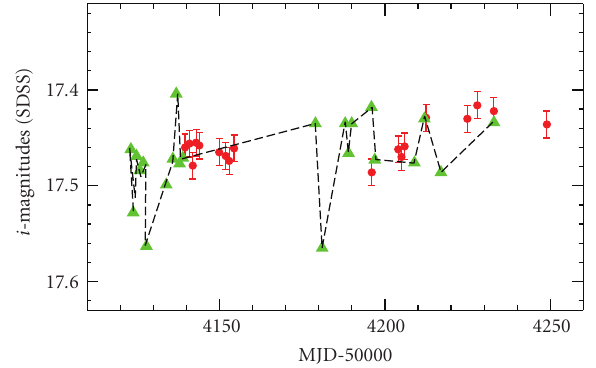
Figure 4: LRT i -band light curves of FBQ 0951 + 2635 in February- May 2007. We compare the record of the A image (red circles) and the time- and magnitude-shifted light curve of the B image (green triangles; the noisy brightness record of B is shifted in time and magnitude, using the 16-day time delay of the system and an average magnitude di ff erence of 1.094 mag). There is a reasonable agreement between both trends, and so we do not find evidence of short-timescale extrinsic variability.